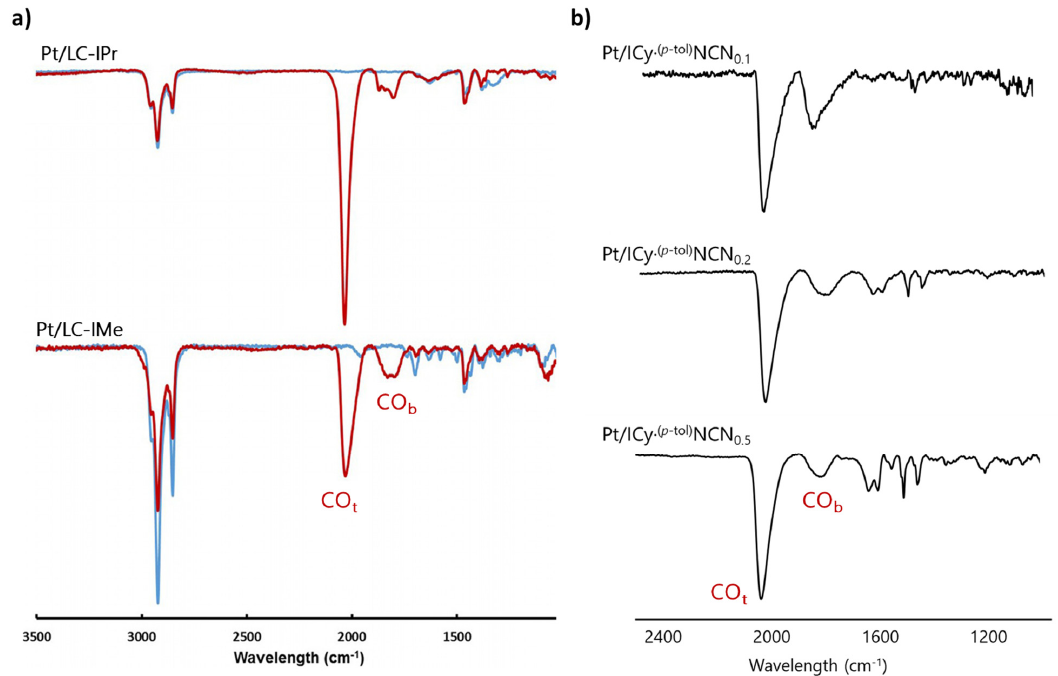
Figure 8. ( a ) FT ‐ IR spectra of Pt/LC ‐ IPr (top) and Pt/LC ‐ IMe (bottom) before (blue) and after (red) CO exposure. Adapted from reference 23 with permission Wiley ‐ VCH. b) FT ‐ IR spectra of Pt NPs stabilized with 0.1 (a), 0.2 ( b ) and 0.5 equivalents of ICy ∙ (p ‐ tol) NCN. Adapted from reference 70. Copyright 2017 The Royal Society of Chemistry.